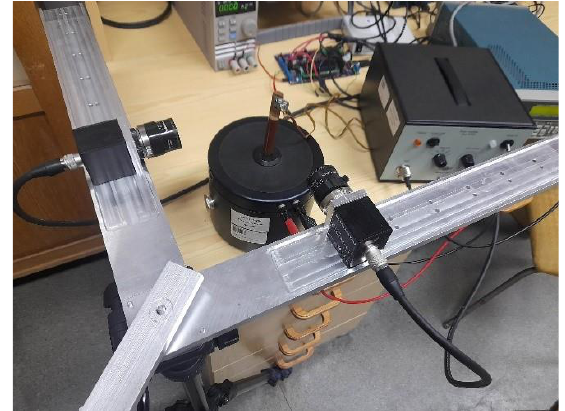
Figure 14. Laboratory stand for vibration measurements. Markers ’ positions within the Cartesian coordinate system are shown in Figure 15. Each of the markers is described by 3 coordinates (X, Y and Z).